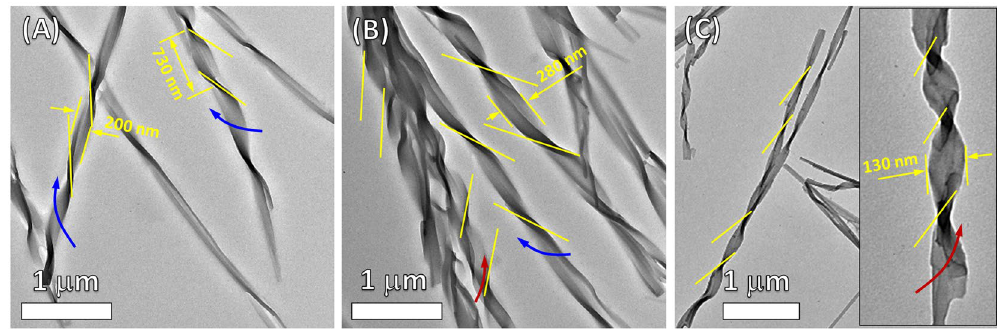
Figure 5. Visualisation of various pH dependent self-assembly by TEM analysis. TEM micrographs of the helical supramolecular microstructures of NDI-L-Glu (1) produced by solvent evaporation at pH ( A ) 3.0 (left handed twisted ribbons), ( B ) 7.0 (a mixture of left and right handed twisted ribbons), and ( C ) 9.0 (right handed twisted